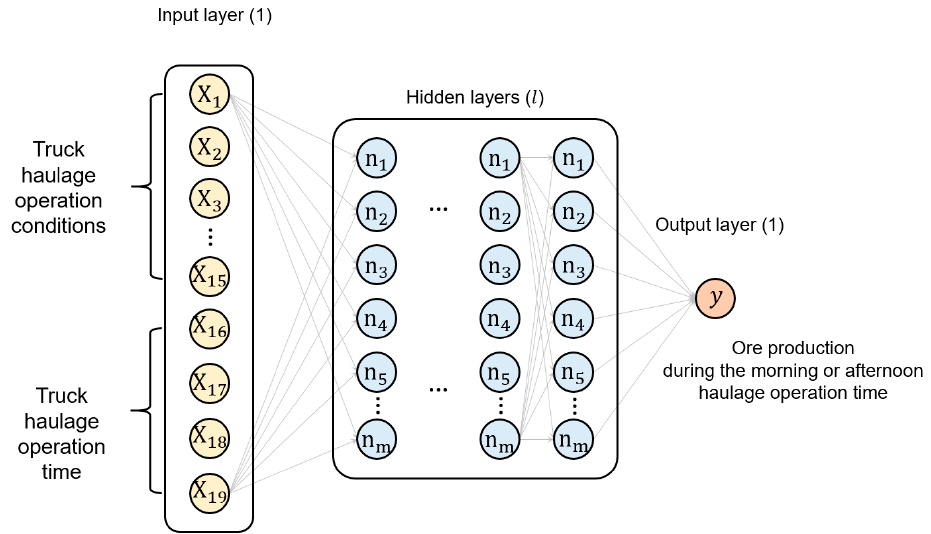
Figure 5. Proposed DNN-model structure to predict ore production during morning and afternoon haulage-operation periods.